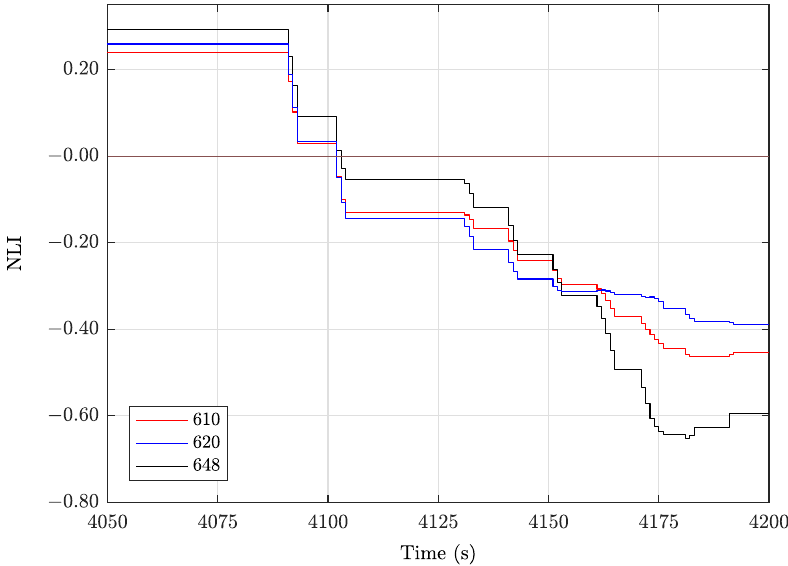
Figure 8. Detail close to NLI change of sign, unstable